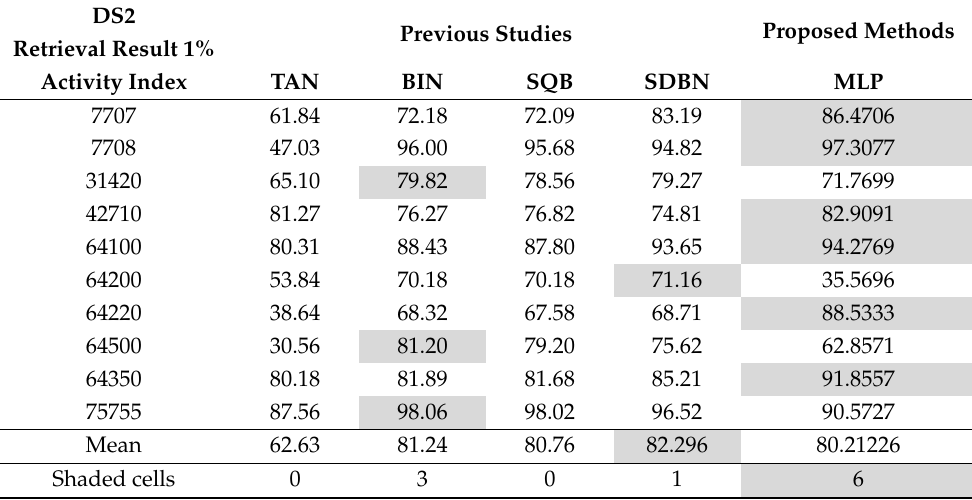
Table 8. Top 1% retrieval results for MDDR-DS2 dataset for descriptor (ECFC